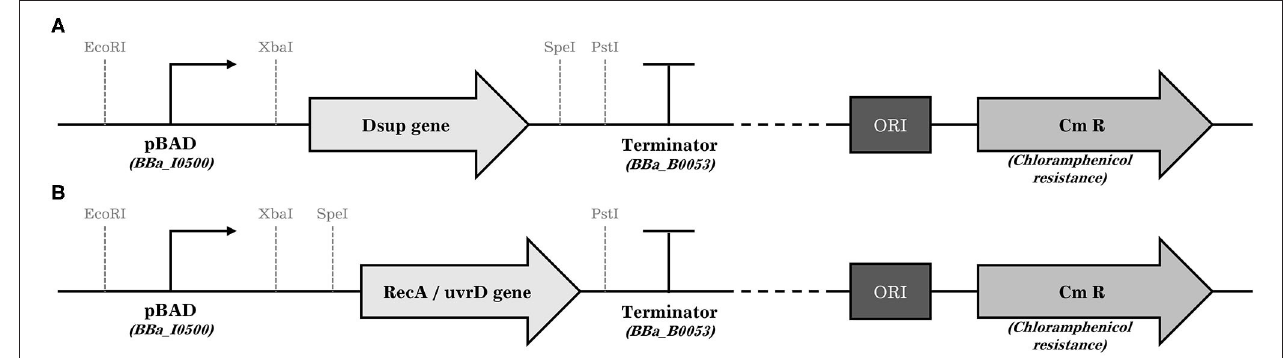
FIGURE 2 | General schemes of the plasmids introduced to the surviving cells. The position of the restriction sites in the case of the Dsup gene (A) and the RecA and uvrD genes (B) , promoter, gene of interest, terminator, the origin of replication, and the chloramphenicol resistance gene is shown.